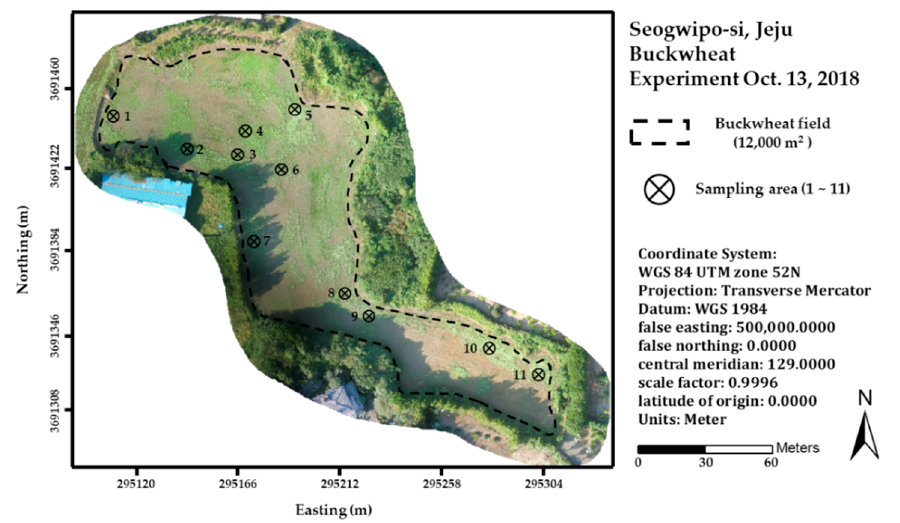
Int. J. Environ. Res. Public Health 2019 , 16 , 3893 Figure 1. Test site: Buckwheat experiment. Figure 1. Test site: Buckwheat experiment.